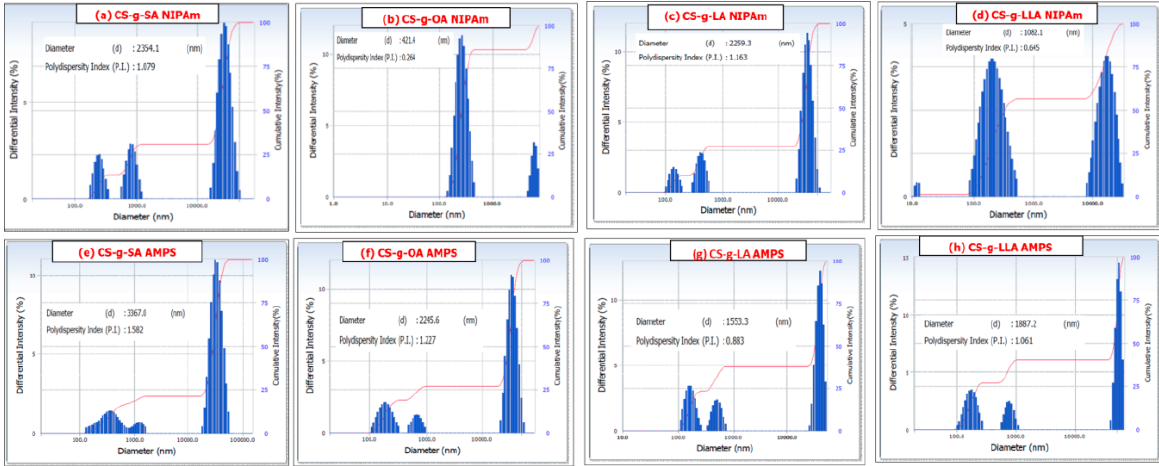
Figure 5. DLS measurements for CS ‐ modified amide with NIPAm and AMPS nanoparticles.